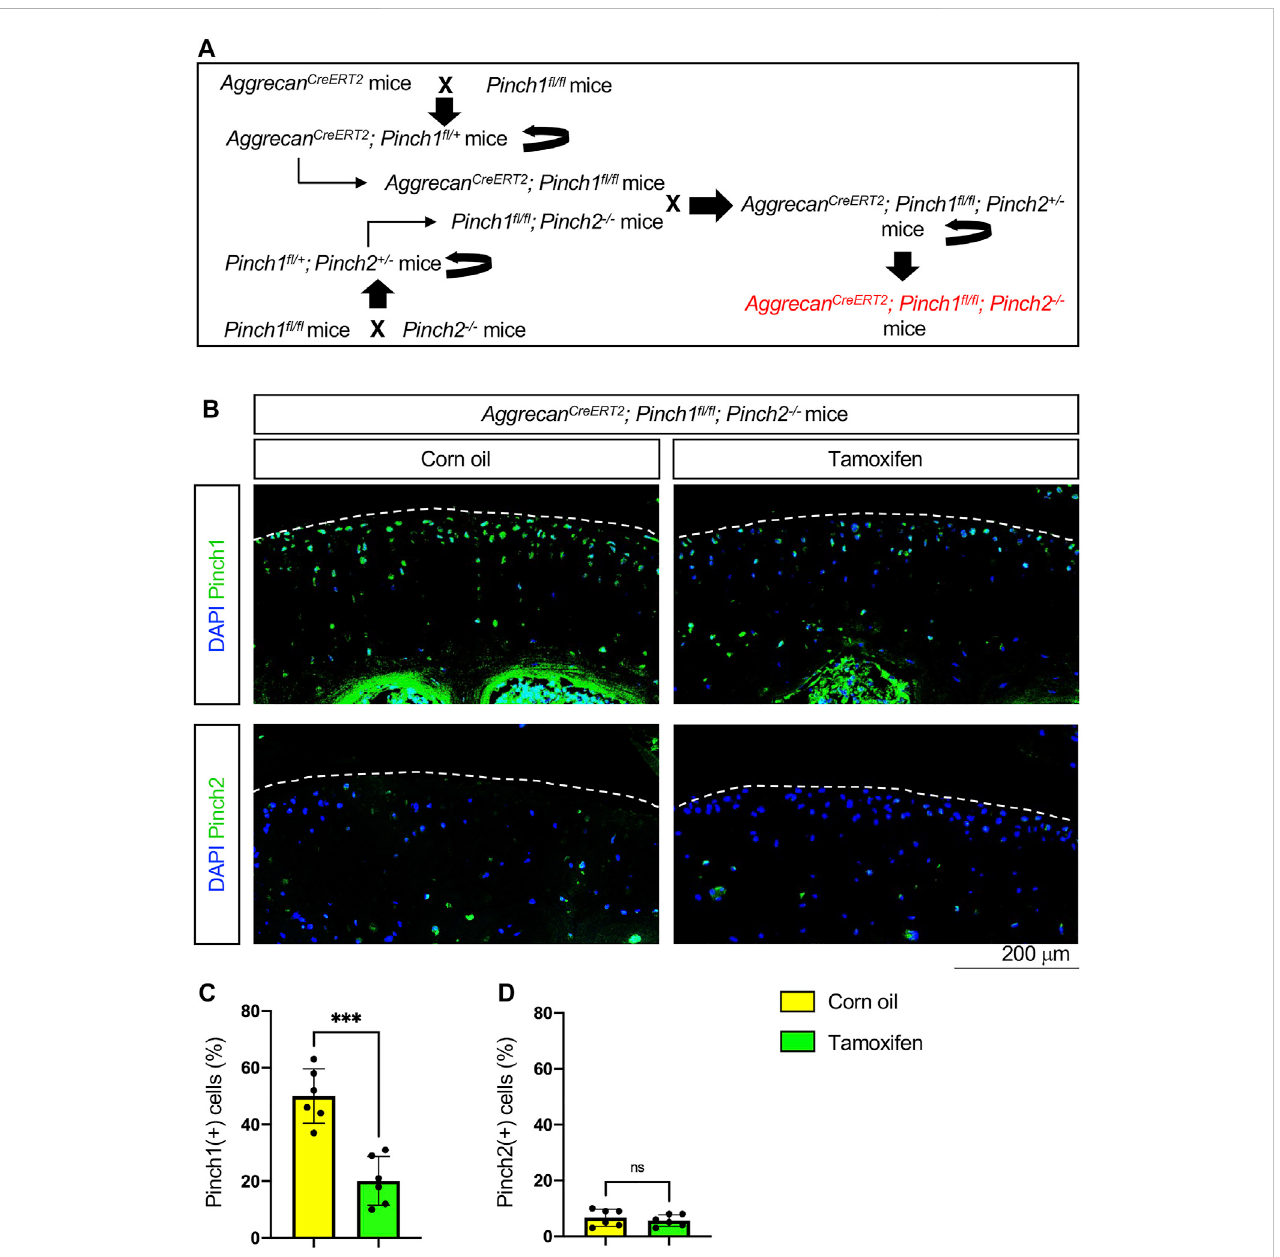
FIGURE 1 Generation of Aggrecan CreERT2 ; Pinch1 fl ox/ fl ox ; Pinch2 − / − mice. (A) A schema showing the breeding of Aggrecan CreERT2 ; Pinch1 fl ox/ fl ox ; Pinch2 − / − mice. TamoxifenwasusedtoinducePinch1deletioninaggrecan-positivechondrocytesin2-month-oldAggrecan CreERT2 ;Pinch1 fl ox/ fl ox ;Pinch2 − / − mice.Cornoilwas used as the control treatment of tamoxifen. (B) Immuno fl uorescence staining images showing the expression of Pinch1 and Pinch2 proteins in articular cartilage of knee joint. Scale bar: 200 μ m. (C – D) Percentages of Pinch1- and Pinch2-positive chondrocytes in tamoxifen- and corn oil-treated Aggrecan CreERT2 ; Pinch1 fl ox/ fl ox ; Pinch2 − / − mice, respectively. Note: N = 6 mice for each group. Results are expressed as mean ± standard deviation (s.d.). *** p < 0.001; **** p < 0.0001.